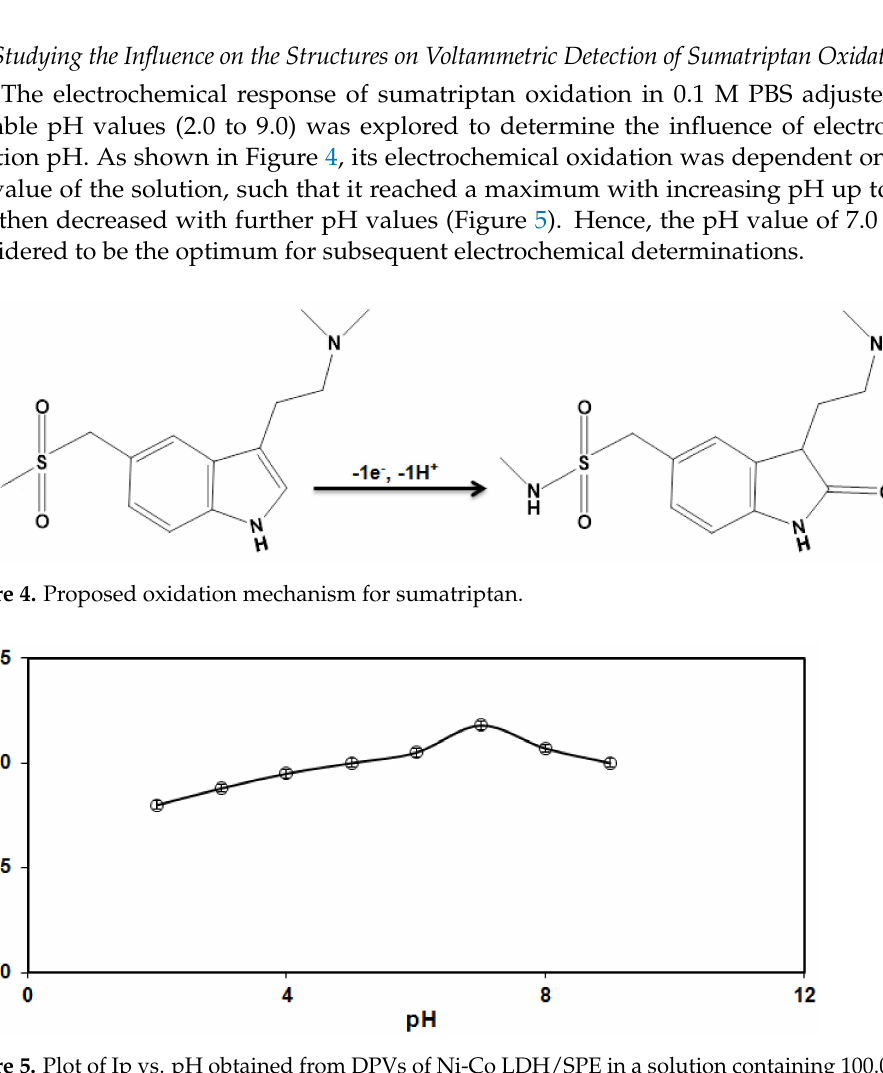
Figure 5. Plot of Ip vs. pH obtained from DPVs of Ni-Co LDH/SPE in a solution containing 100.0 µ M of sumatriptan in 0.1 PBS with different pH (2.0, 3.0, 4.0, 5.0, 6.0, 7.0, 8.0, and